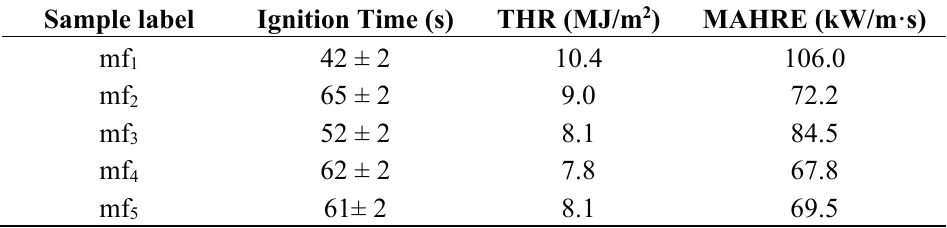
Figure 4. Heat release rate of the nonwoven samples. Table 6. Cone calorimeter parameters for the different PP nonwoven